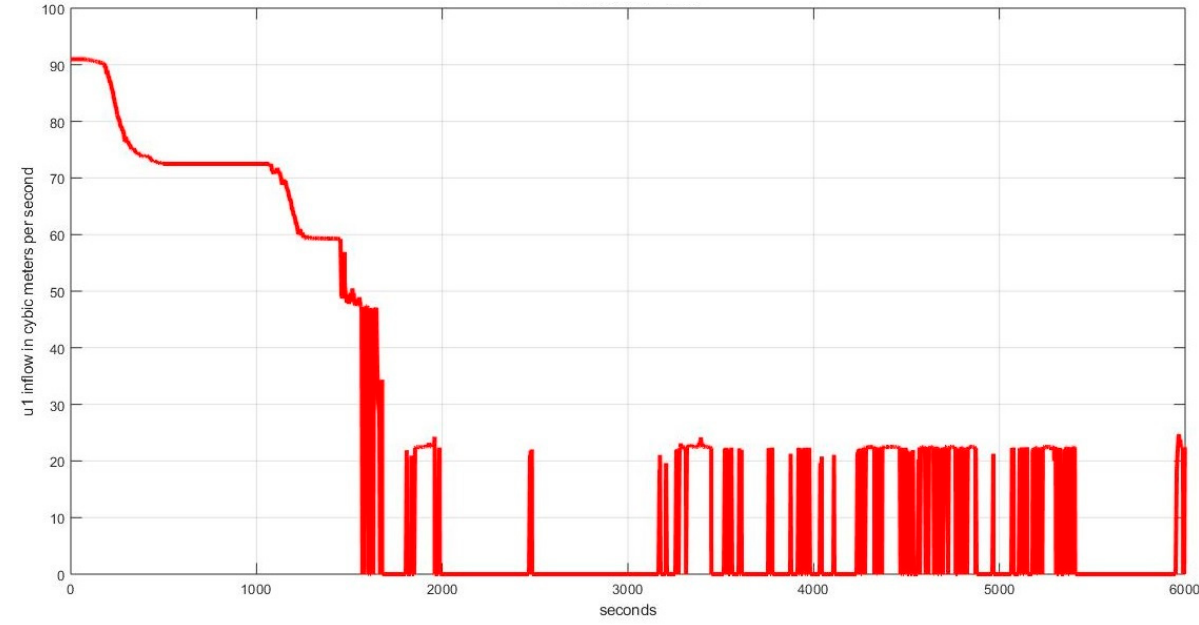
Figure 21. U1 control variable indicating the water inflow for case of white noise disturbance.